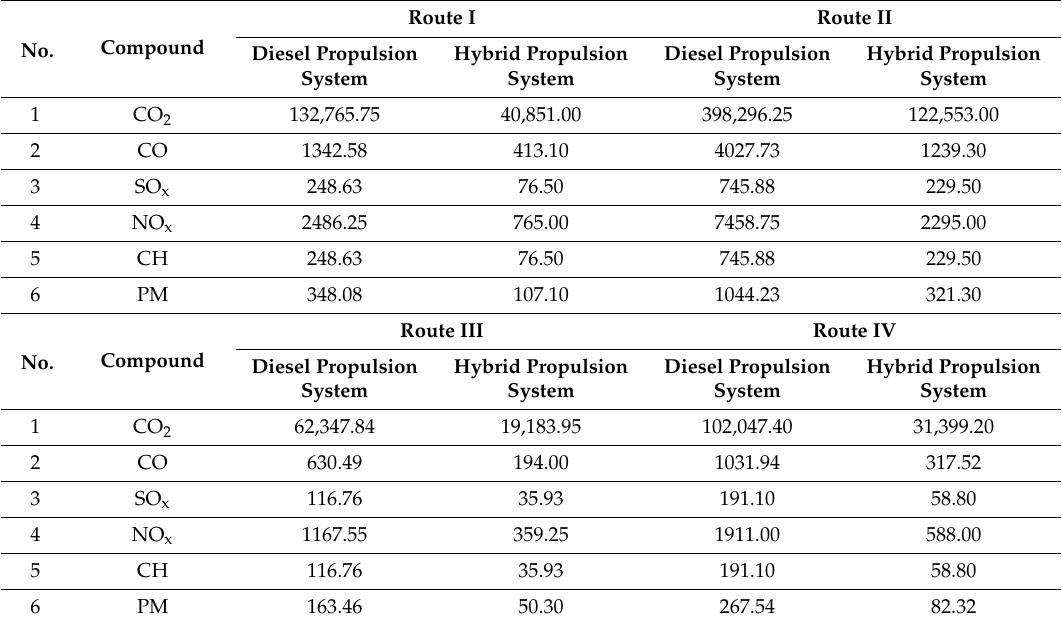
Table 5. Estimated volumes of atmospheric emissions for the proposed ferry routes